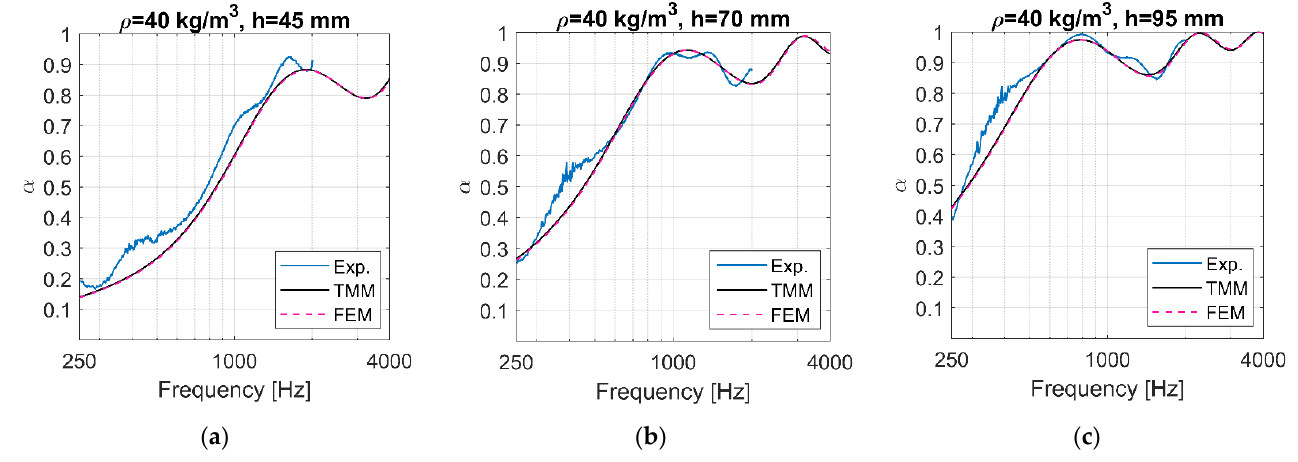
Figure 7. Comparisons between experimental results, TMM and FEM for RPU foams with ρ = 40 kg/m 3 .